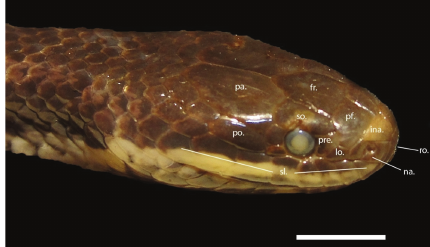
Figure 3: Dorsal view of the skull of Sordellina punctata (IBSP 22313). Bar = 5mm. Exo: exoccipital; f: frontal; mx: maxilla; n: nasal; p: parietal; pf: prefrontal; pm: premaxilla; po: postorbital; sm: septomaxilla; so: supraoccipital; st: supratemporal.